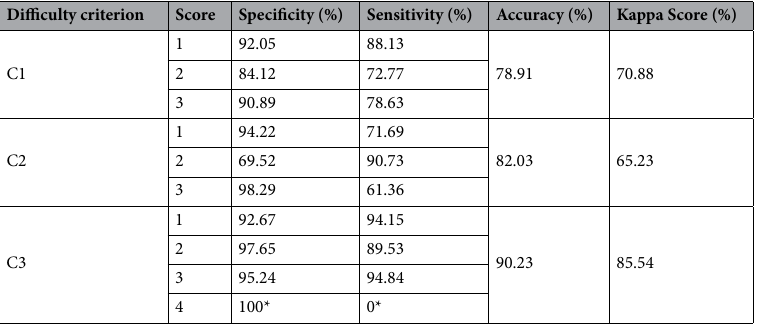
Table 1. Classification results. C1 depth, C2 ramal relationship, C3 angulation. Superscript (*) indicates that the data in that particular case were insufficient.